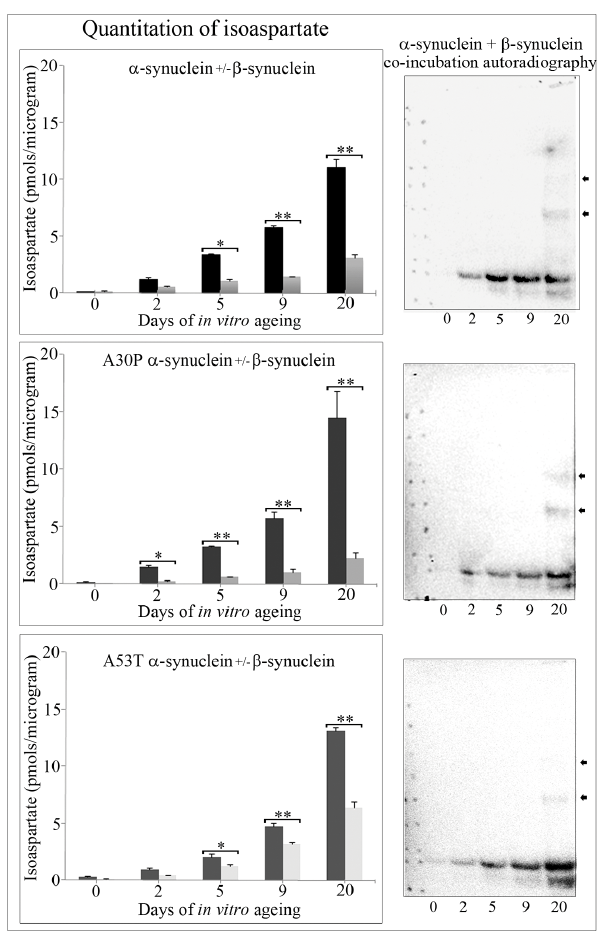
Figure 7. Quantitation of isoaspartate formation during invitro ageing of a -synuclein either with or without co-incubation with b -synuclein, and co-incubation autoradiography. Alpha-synu- clein, A30P mutant a -synuclein, or A53T mutant a -synuclein were in vitro aged either with or without b -synuclein over a time course of up to 20 days. Two and a half m g of protein was removed after 0, 2, 5, 9, and 20 days of in vitro ageing and the level of isoaspartate formation quantified by a methanol diffusion assay (left panels). Black filled columns correspond to a -synuclein isoaspartate values, grey filled columns correspond to isoaspartate levels from a -synuclein co- incubated with b -synuclein. Co-incubation of b -synuclein with a - synucleins significantly reduced total isoaspartate formed during the in vitro ageing time course. Significance is marked with an asterisk: *p , 0.01; **p , 0.001. Synuclein proteins from co-incubation experi- ments were methylated with 3 H-SAM using exogenous PIMT, resolved by 1D PAGE, and isoaspartate methylation visualised by autoradiogra- phy (right panels). Stable a -synuclein protein oligomers that contained isoaspartate peptide linkages are marked with